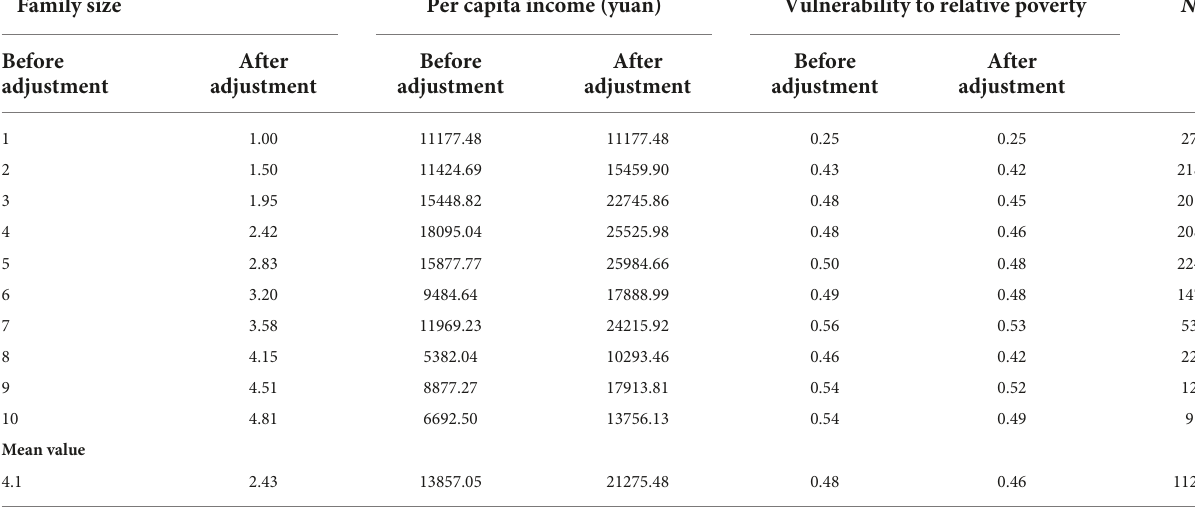
TABLE 8 Comparison of family characteristics before and after adjustment of equivalent size.